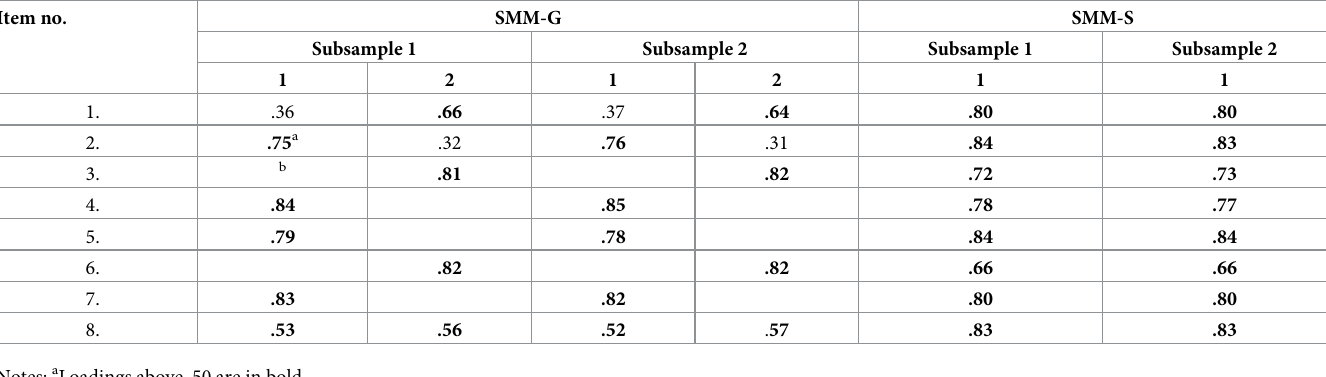
Table 4. EFA results for the SMM-G and SMM-S: Factor loadings (Study 1). Item no.